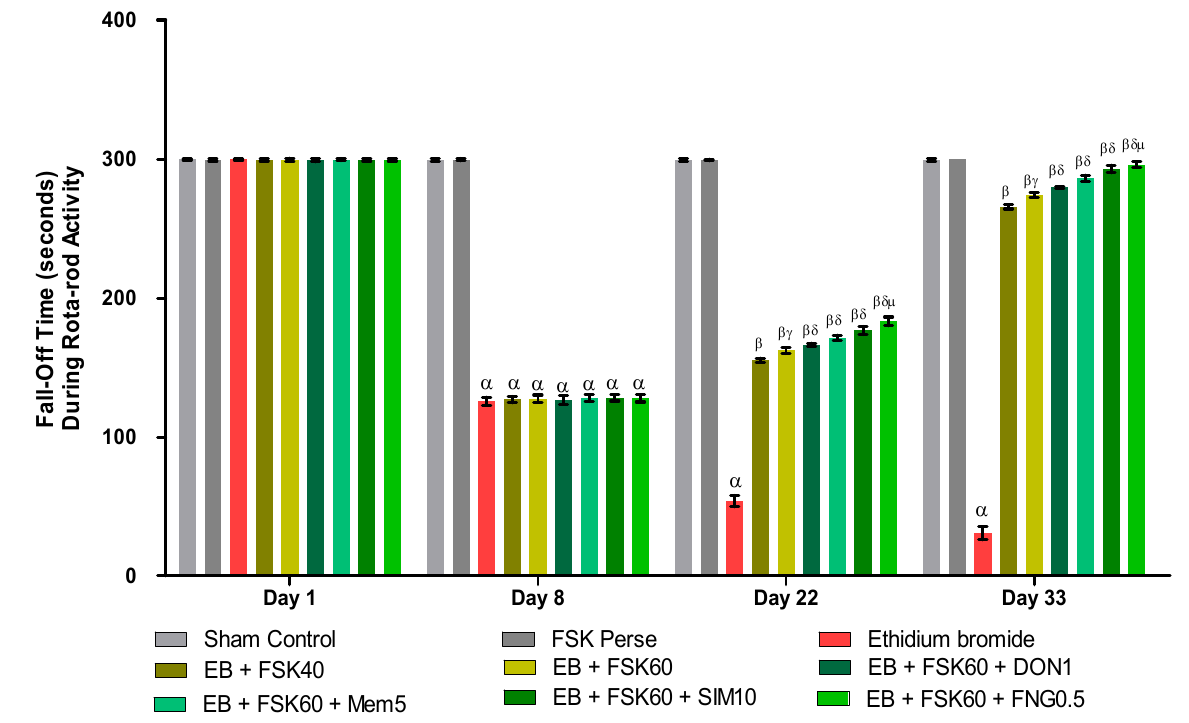
Figure 6. Protective role of FSK rotarod in experimental multiple sclerosis rats. Analysis of Variance (ANOVA) with Bonferroni’s post hoc test was used to evaluate the data, which were presented as mean with SD ( n = 6). α EB (p < 0.01) v / s Sham control and FSK40 perse; β EB + FSK40, EB + FSK60, EB + FSK60 + DON1, EB + FSK60 + MEM5, EB + FSK60 + SIM10, EB + FSK60 + FNG0.5 (p < 0.01) v / s EB; βγ EB + FSK60 (p < 0.01) v / s EB + FSK40; βδ EB + FSK60 + DON1,EB + FSK60 + MEM5, EB